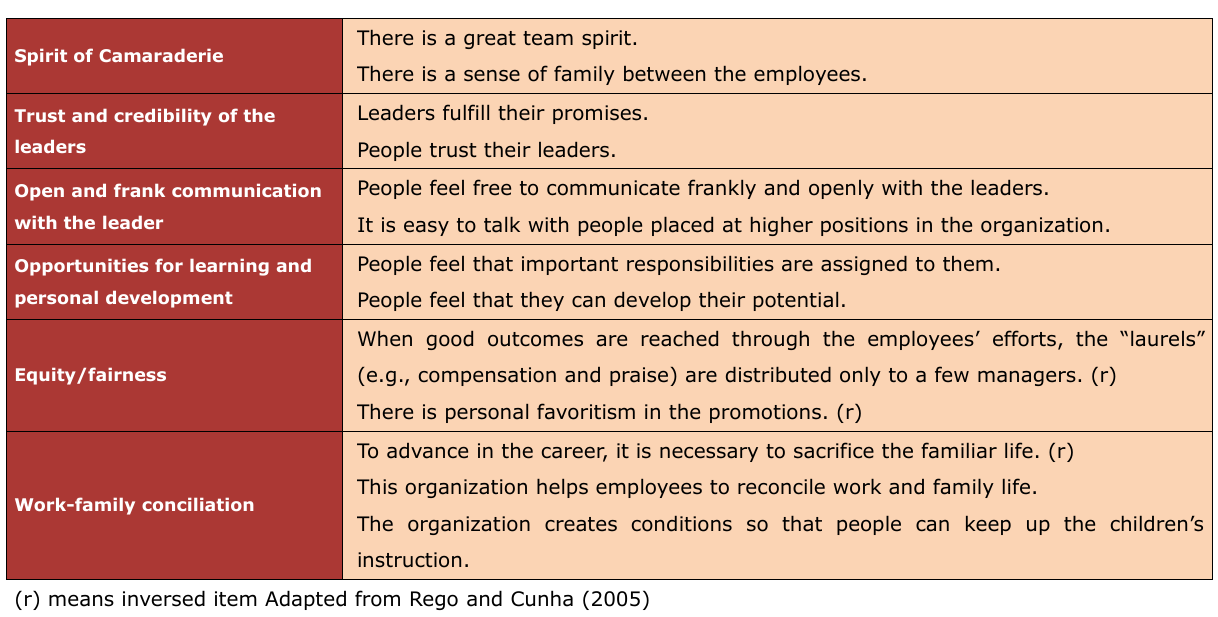
Table 2. Authentizotic dimensions